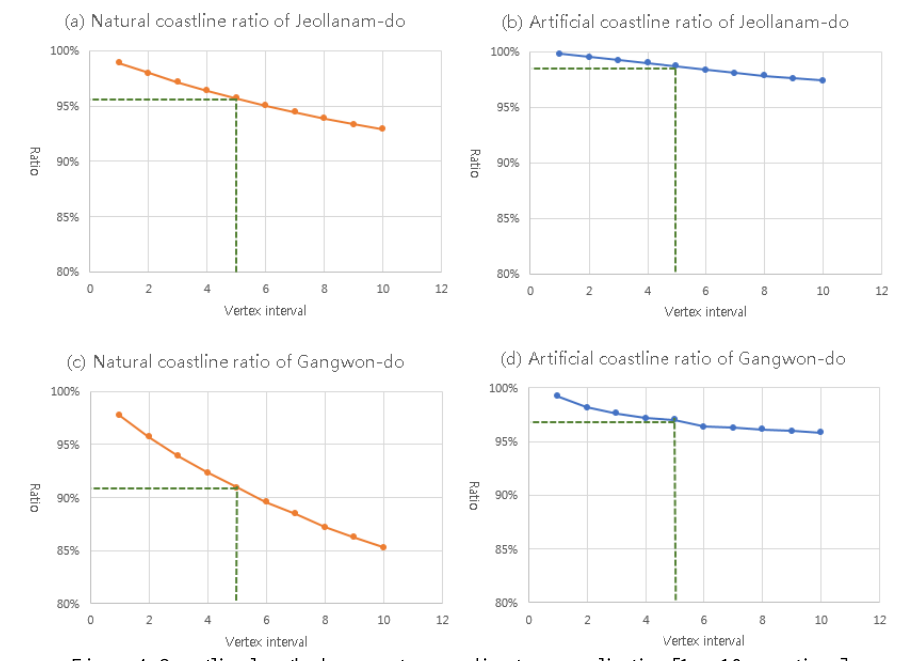
Figure 4. Coastline length change rate according to generalization [1m~10m